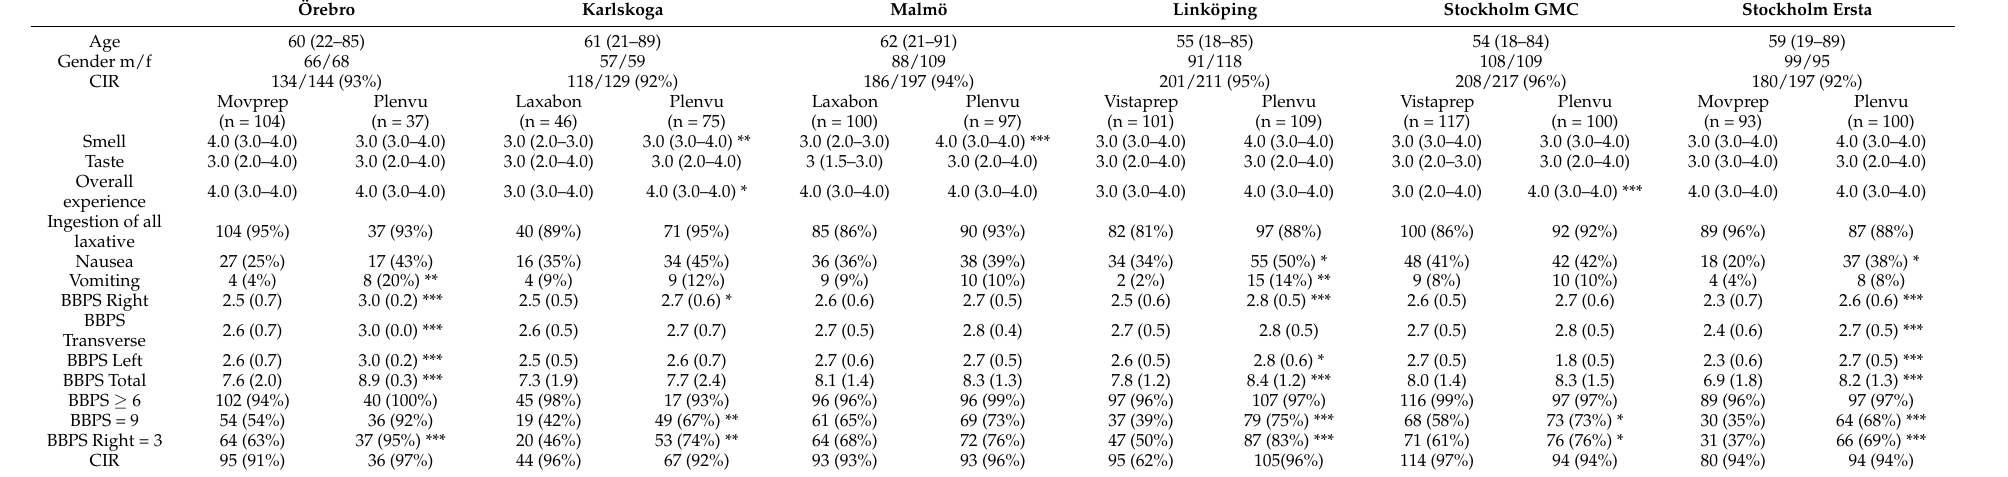
Table A1. Comparison between the different endoscopy